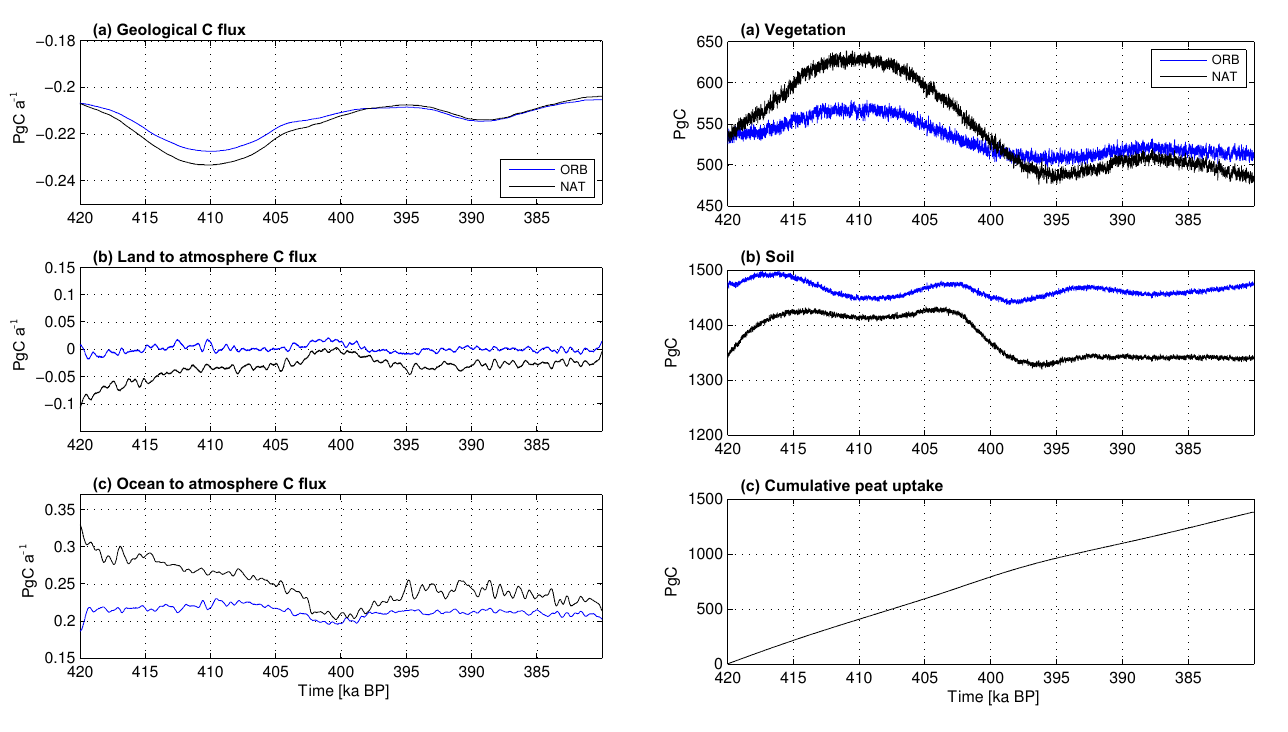
Figure 12. Land carbon pools in the MIS 11 experiments: total vegetation carbon (a) , total non-peat soil carbon (b) and cumulative C uptake by peatlands (c)